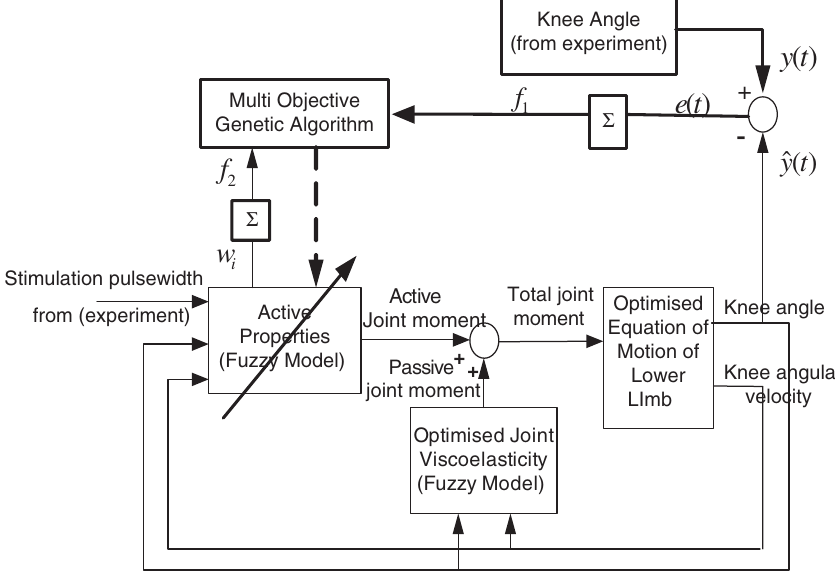
Fig. 5. Optimization of active